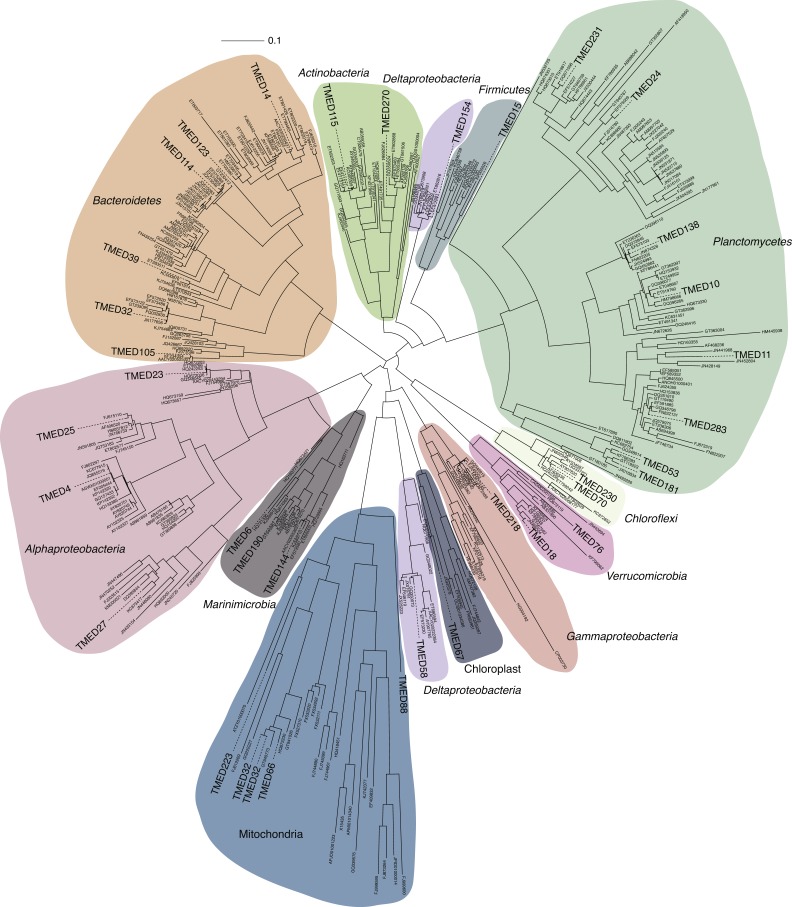
FastTree approximate maximum-likelihood phylogenetic tree constructed with 37 and 406 16S rRNA genes from putative draft genomes and references, respectively.Sequence alignment is available in Supplemental Information 4. Phylogenetic tree with Shimodaira–Hasegawa local support values as available in Newick format in Supplemental Information 5.